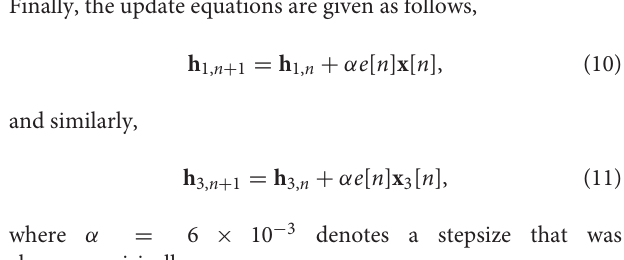
drive the single speaker and recorded the sound